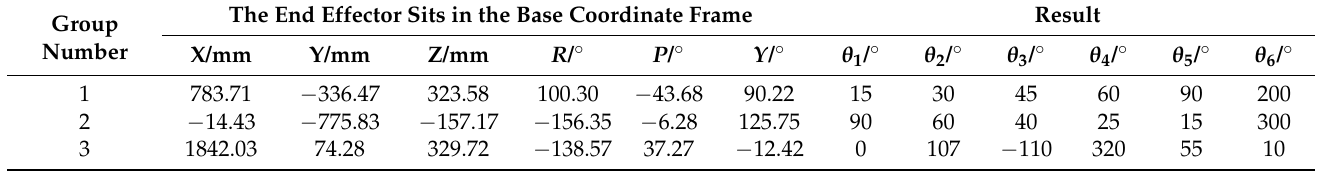
Table 3. Results of inverse kinematics